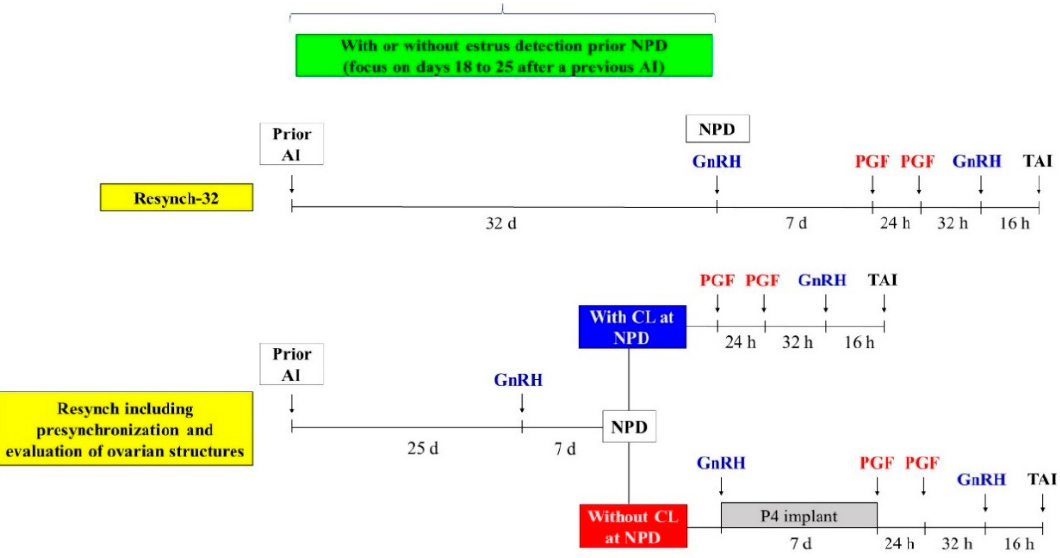
Figure 5. Schematic representation of two commonly used reinsemination programs, designed to reduce the interval between timed artificial insemination (TAI) and optimize fertility. The timing of nonpregnancy diagnosis (NPD) is the same in both protocols (32 days after AI) and is a commonly used timing in herds using transrectal ultrasound for pregnancy diagnosis. The upper strategy is Resynch-32, while the lower strategy is designed to produce earlier TAI in most non-pregnant cows and to improve fertility to the TAI by using a corpus luteum (CL) evaluation at the NPD ultrasound. Gonadotropin-releasing hormone (GnRH), prostaglandin F2 α (PGF), progesterone (P4).